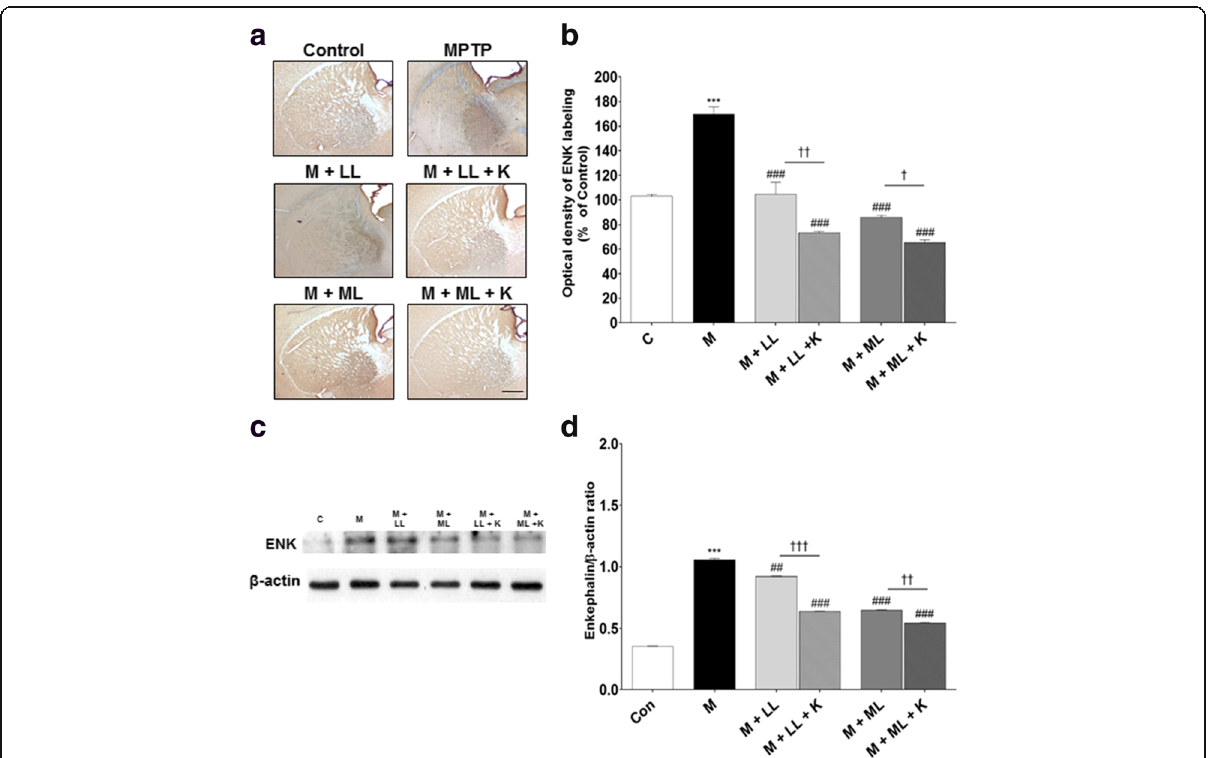
Fig. 5 Effects of combination treatment on ENK expression in the GPe. Immunohistochemical analyses of ENK expression in the GP ( a , b ). Western blot analyses of ENK expression in the GP ( c , d ). The MPTP group showed higher ENK immunoreactivity in the GPe, but combination treatment reduced ENK expression in the GP. C: control, M: MPTP, K: KD5040, LL: low dose of (10 mg/kg). *** p < 0.001 vs. control, ### p < 0.001 vs. MPTP, and †† p < 0.01 vs. each dose of L -dopa. Error bars represent SEM. Scale bar: 200 μ m. ENK: enkephaline; GPe: external segment of globus